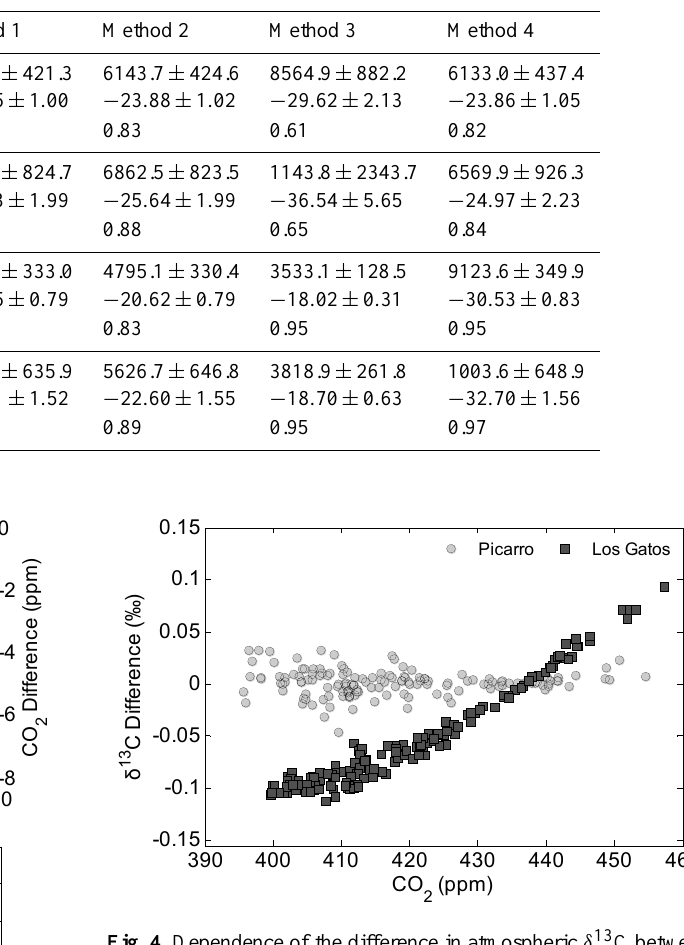
Table 2. Keeling mixing-line analysis of ambient measurement in Beijing during DOY 103–110 in 2012. The regression was made using the calibrated δ 13 C against the reciprocal of the calibrated CO 2 concentration. Gas standards Std1 and Std3 were used for Methods 1–3 and Std3 was used for Method 4.